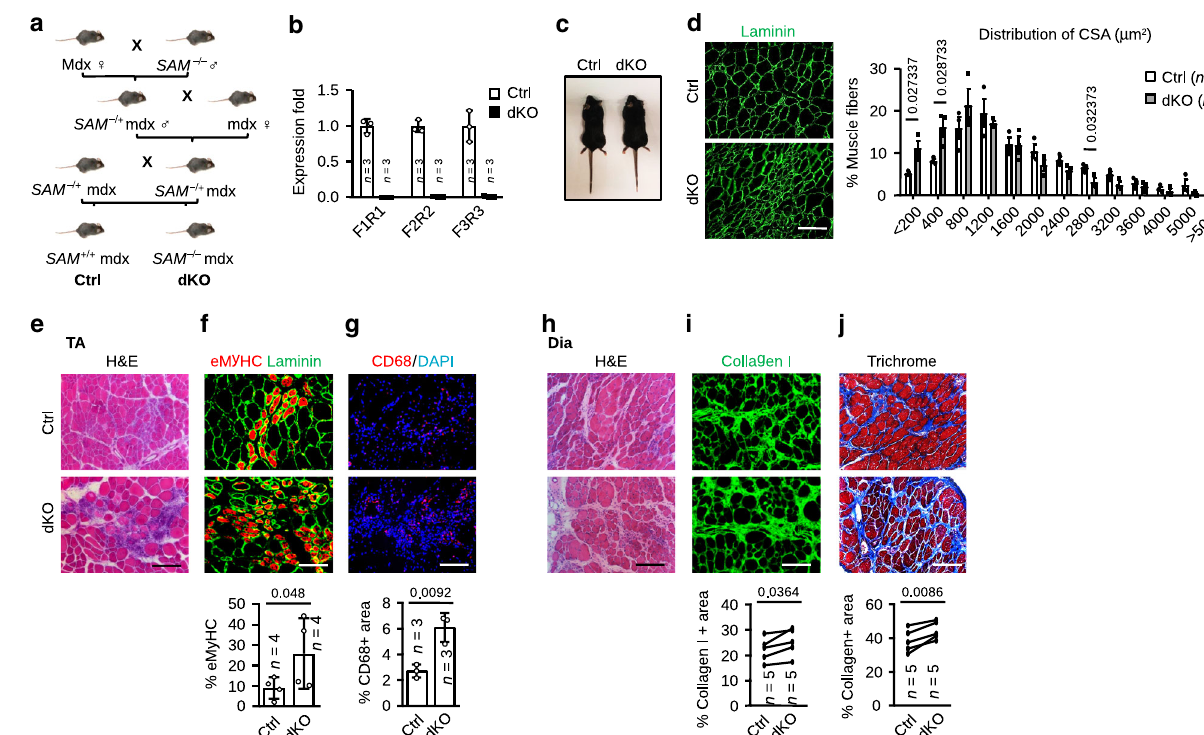
Fig. 3 SAM deletion aggravates dystrophic phenotype in mdx mice. a Schematic showing the generation of SAM and DMD double KO mice (dKO) through breeding mdx and SAM KO mice. b qRT-PCR was performed to con fi rm the loss of SAM in SCs of dKO vs. Ctrl mice. c Representative images of Ctrl and dKO littermates. d IF staining of Laminin was performed on TA muscles from 8 weeks old Ctrl and dKO mice and the cross-sectional area (CSA) of individual myo fi bers was quanti fi ed. The percentage of myo fi bers with a de fi ned range of CSA over the total myo fi bers was calculated for each mouse. More than 1500 myo fi bers from three pairs of littermates were counted. e H&E and f eMyHC and Laminin staining was performed on the above TA muscle and the percentage of eMyHC + fi bers per fi eld was quanti fi ed. g IF for CD68 was conducted on the above muscles and macrophage in fi ltration was assessed by quantifying the percentage of CD68 positive areas per fi eld. h Diaphragm muscles (Dia)were isolated from 6 to 8 months old Ctrl and dKO mice and H&E was performed. i Staining of Collagen I was performed on the above Dia muscles and quanti fi cations of the percentage of Collagen I positive areas per fi eld are shown below the images. j Masson ’ s Trichrome staining was performed on the above Dia muscles and the positively stained areas were quanti fi ed. The data are presented as mean ± SD in b , f , and g and mean ± SEM in d . The p values by two-tailed unpaired t test are indicated in d and g , two- tailed ratio paired t test in f and two-tailed paired t test in i and j . The total number of mice used are indicated in b , d , f , g , i , and j . Scale bars: 50 µ m j , 100